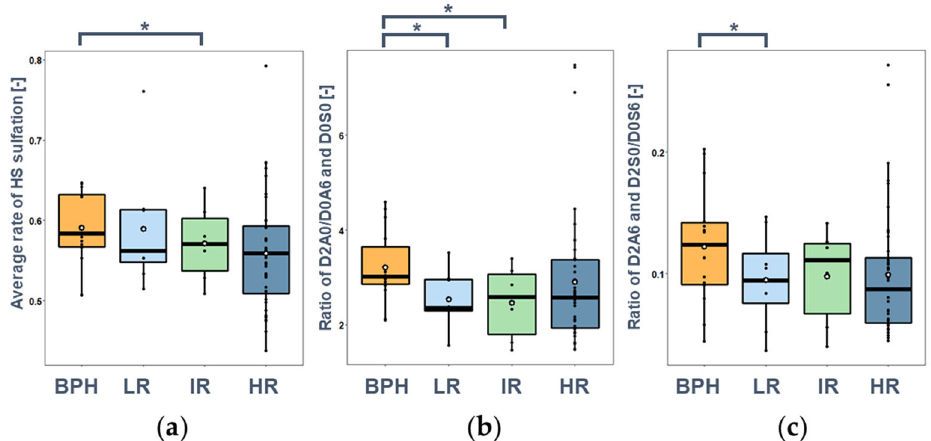
Figure A3. Sulfation characteristics of HS chains as a function of the risk stratification based on Gleason scores: ( a ) average rate of HS sulfation; ( b ) O/N ratio of the monosulfated disaccharides; ( c ) O/N ratio of the disulfated disaccharides. (*: p < 0.05). See Figure 1 for resolving the GAG structure codes.